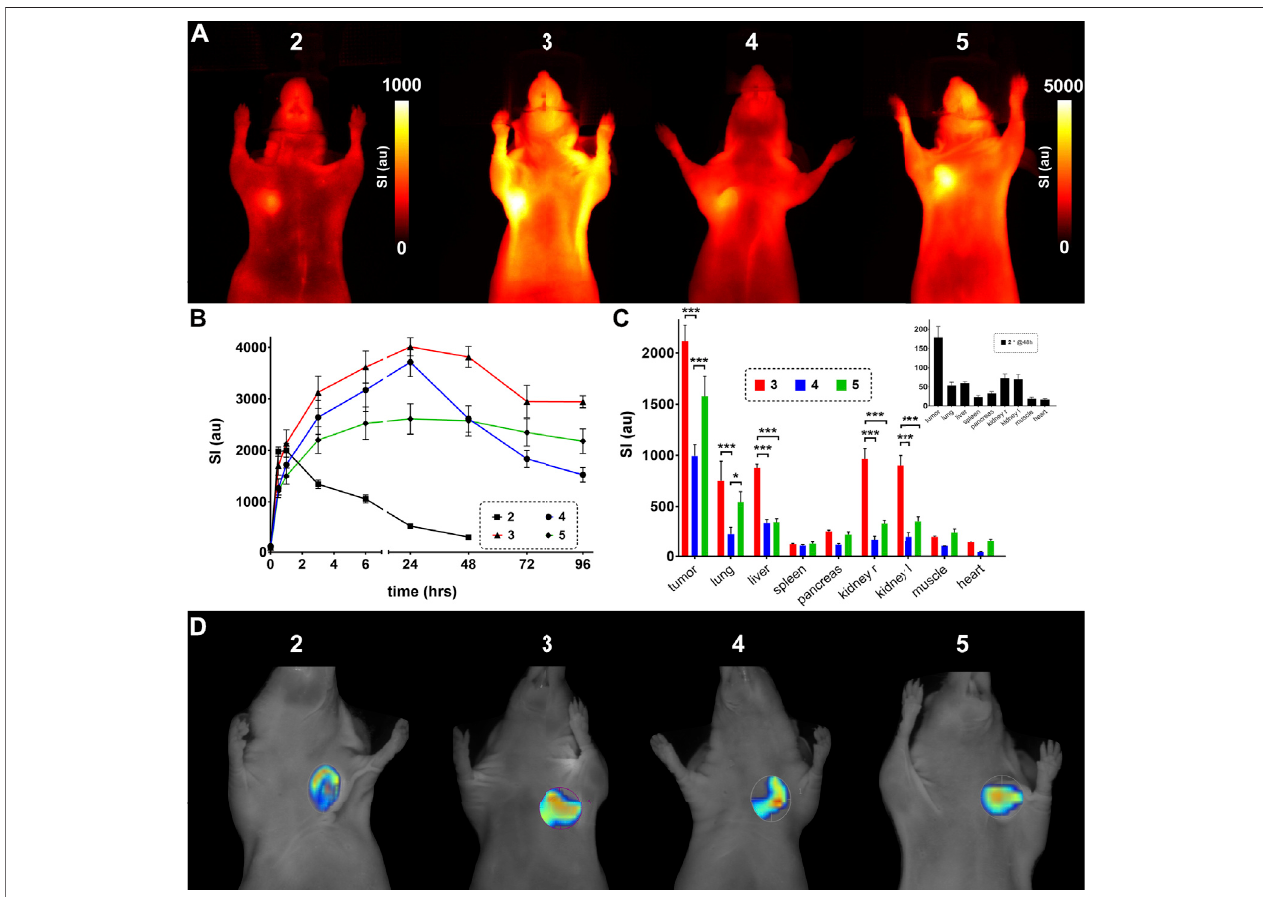
FIGURE 6 | In vivo evaluation of the designed probes 2 – 5 in nude mice bearing U87MG xenografts. (A) FRI images 48 h after injection of the probe. Note the differenceinscalebetweenprobe 2 andprobes 3 – 5 . (B) Timelineof fl uorescencesignalintensity(au)fromtumortissue invivo .Probe 2 wasonlyinvestigatedfor48 hdue to the high signal decay (signi fi cant SI differences are listed in Supplementary Table S1 ). (C) Biodistribution of organ fl uorescent signal 5 days (96 h) after probe injection (inset, biodistribution of 2 after 48 h). (D) Exemplary FMT images including regions of interest around tumor tissue (unscaled).